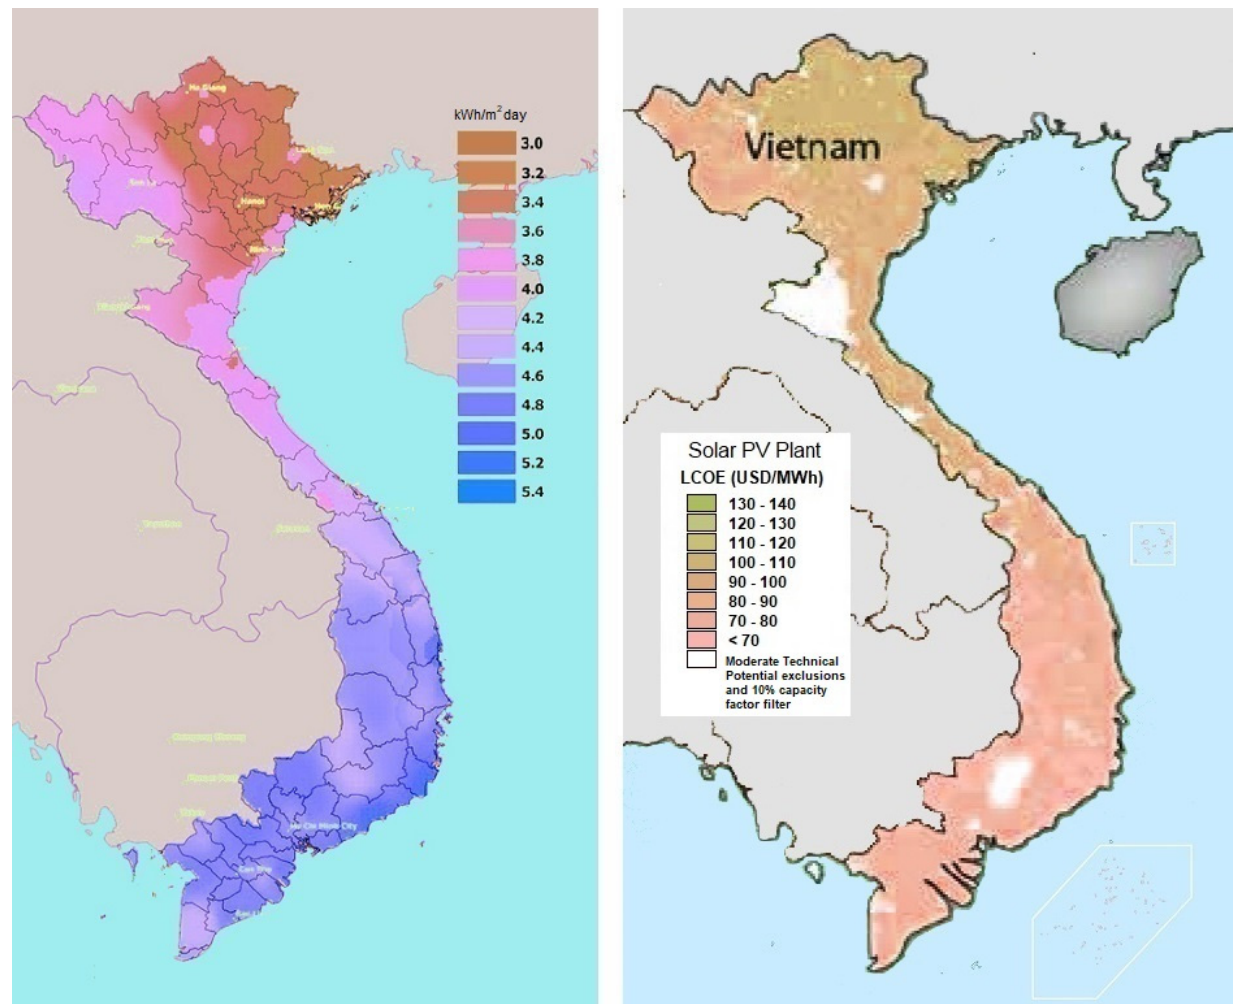
Figure 12. Solar potential and LCOE for SPP in Vietnam in 2019–2020. Reprinted with permission from Refs. [66,67]. Copyright 2015 Vietnam Ministry of Industry and Trade & Spanish Agency for